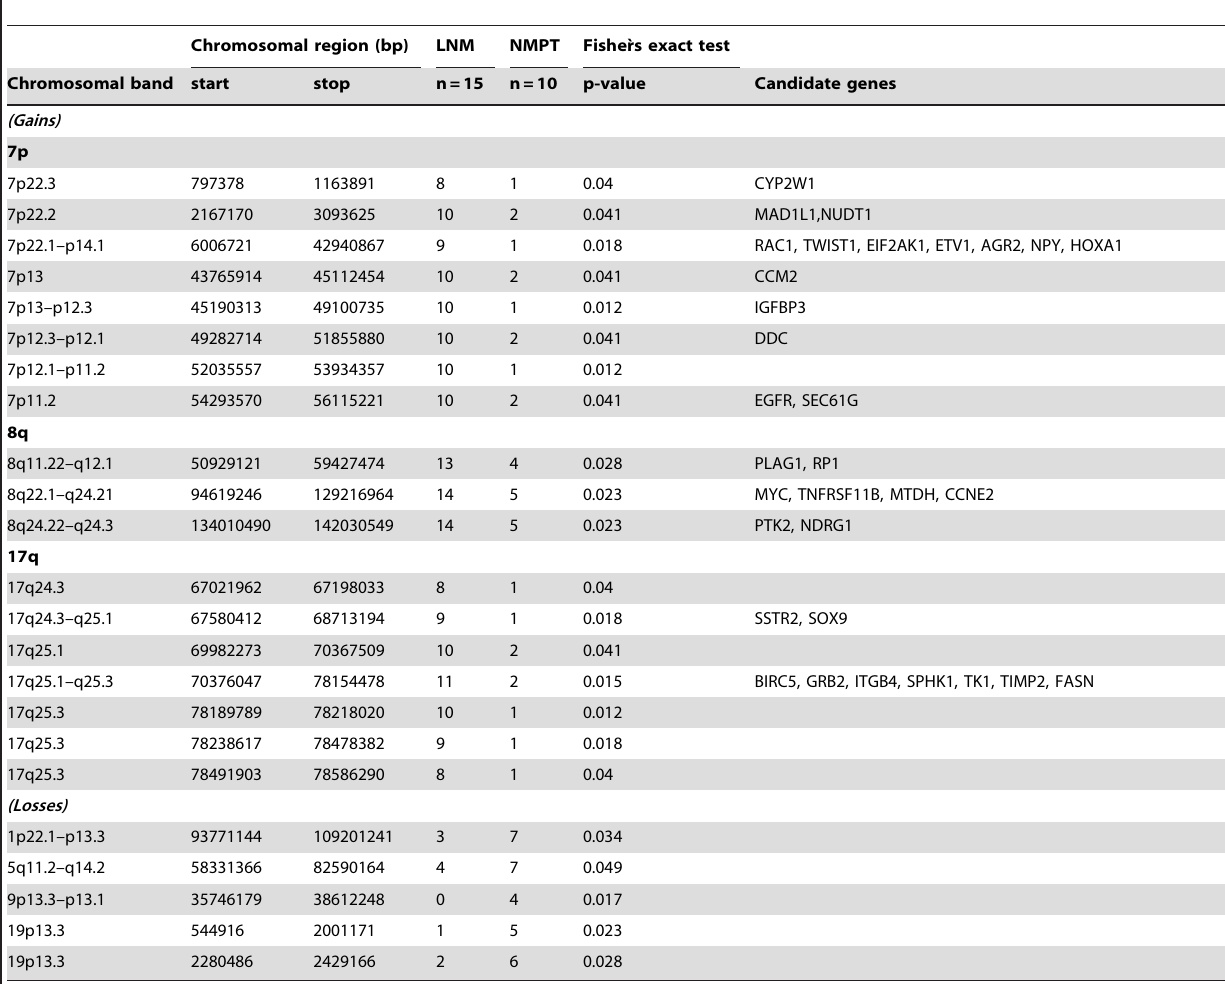
Table 2. Genomic CNAs with potential candidate genes found to differ significantly between LNMs and